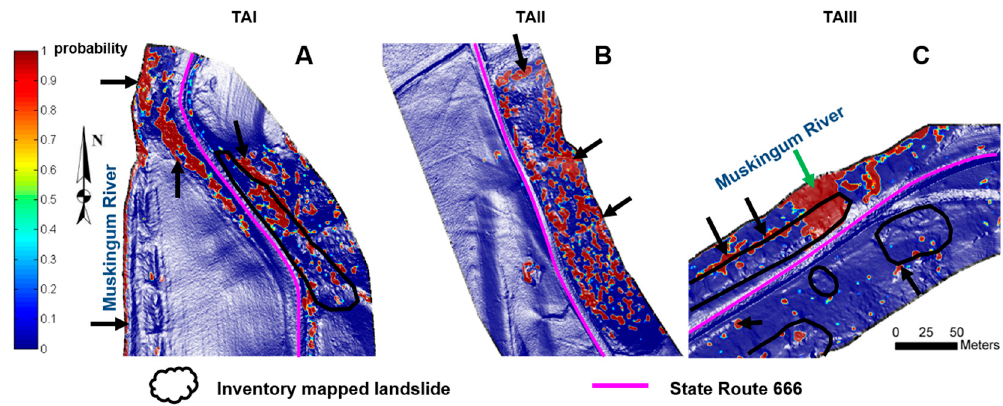
Figure 7. Illustrated in ( A – C ) are the probabilities (signed rank test) for TAI, TAII and TAIII, respectively, for a local neighborhood of 7 × 7 cells and M = 0.17 m. Examples of areas undergoing high probable change are depicted by arrows.